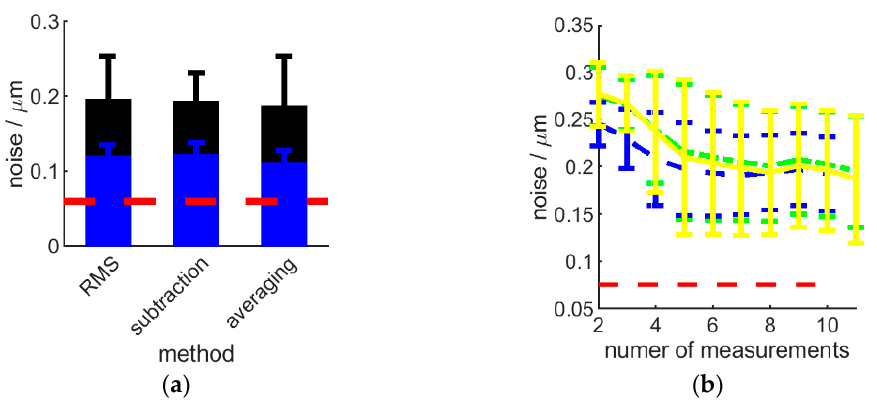
Figure 2. Comparison of noise estimation methods. Representative comparison of noise measures for metal (blue) and glass (black) flat surfaces are shown on ( a ) with solid bars representing the mean value and the standard deviation over 11 repeated measurements is illustrated by the single-sided positive error bar. Noise convergence for all methods (RMS: green, subtraction: blue, averaging: yellow) is shown on ( b ) for a glass surface. R5 optics and highest Z resolution used. Red dashed lines show the noise level on the averaged surface (resulting from averaging 11 single surface measurements) using the RMS method.